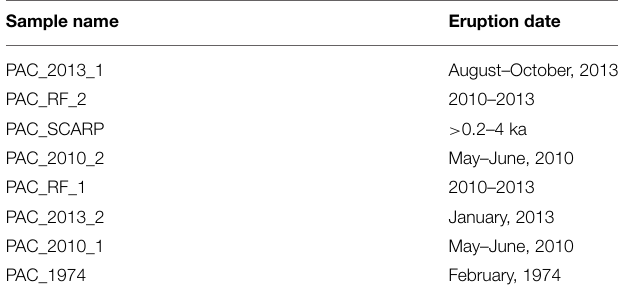
TABLE 1 | Sample names and eruption